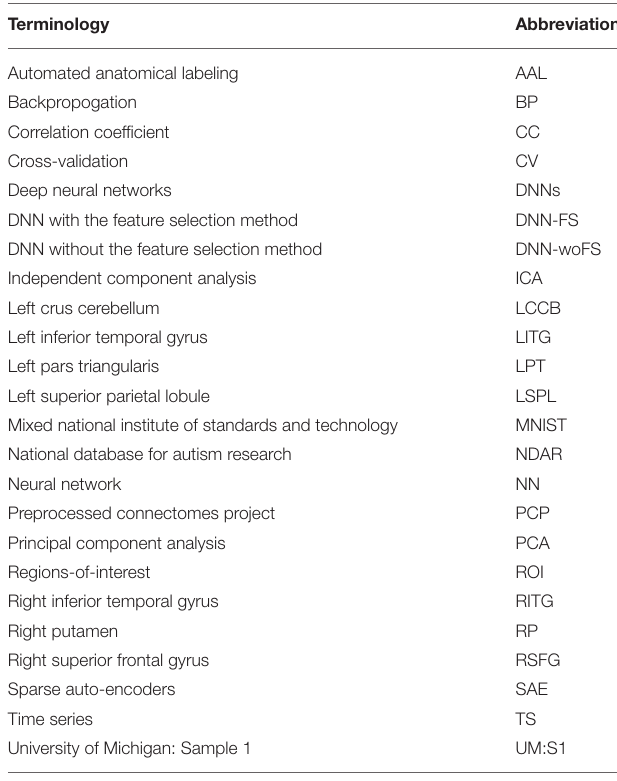
TABLE 1 | Abbreviation of terminologies used in sections Materials and Methods, Results, and